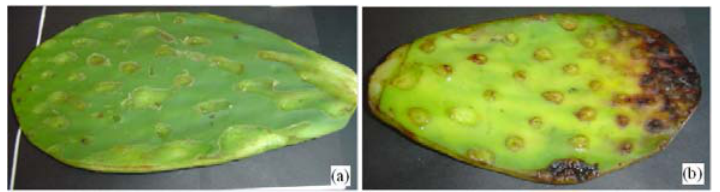
Figure 1. ( a ) Fresh nopal cactus ( Opuntia ficus-indica ); ( b ) Observe the color change from green to dark brown in the